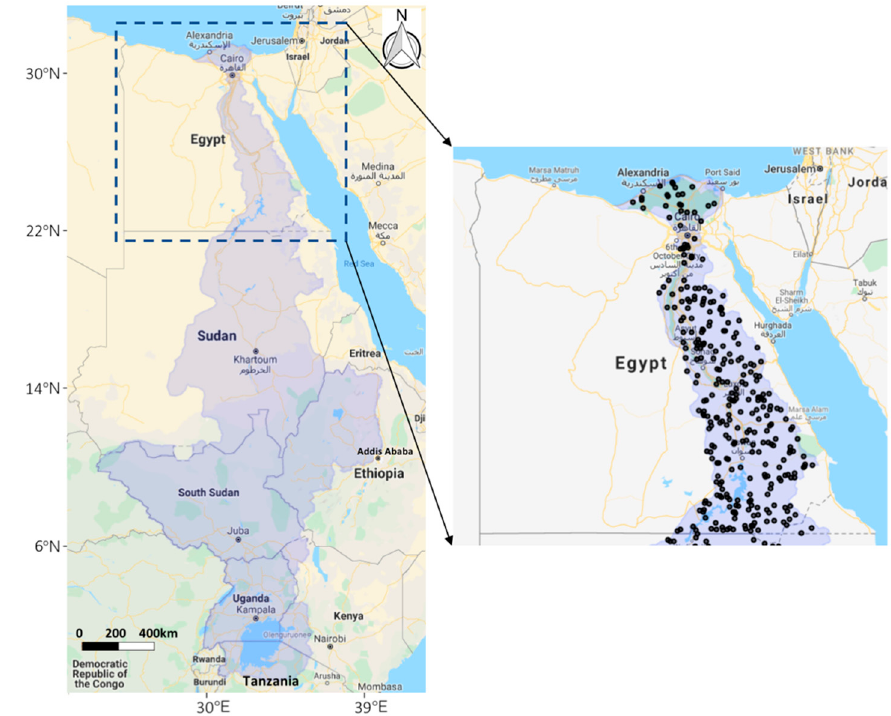
Figure 1. Left: the map of countries in the Nile watershed region and the selected capital cities (Cairo, Khartoum, Juba, Addis Ababa and Kampala) in this study. Right: sample points collected in Egypt. Table 1. The countries in the Nile watershed under investigation in this research.